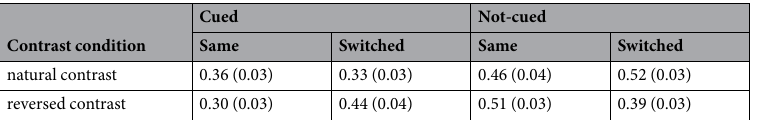
Table 1. Average relative looking times (standard errors) to objects in each combination of cue (cued and not- cued) and object position (same and switched) in both contrast conditions (natural and